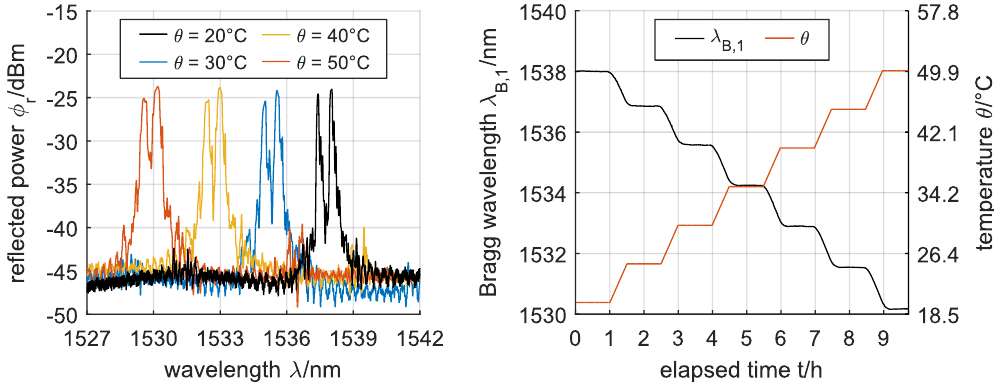
Figure 4. Reflection spectra of a waveguide Bragg grating in OrmoClad ( left ) and the correspondingly detected and tracked Bragg wavelength shift of λ B,1 depending on the temperature at a relative humidity of 30% ( right